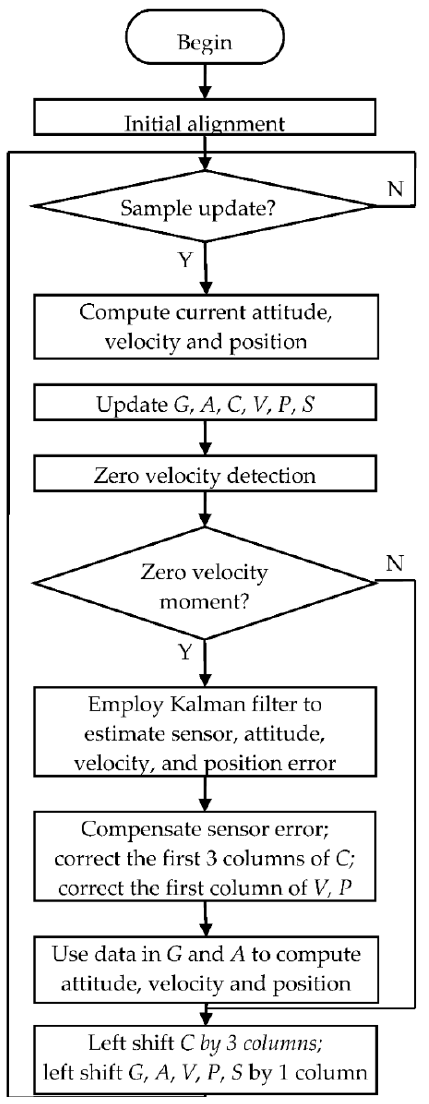
Figure 6. Pedestrian navigation system software flow chart.